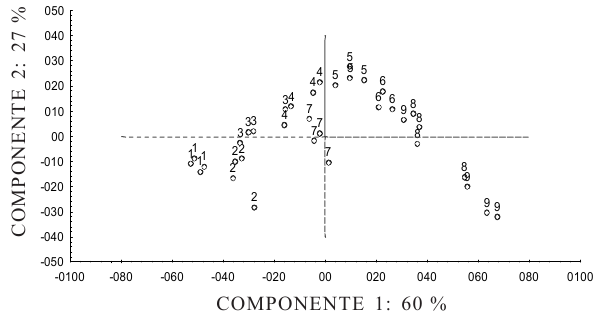
Figura 4. Projeção dos dois componentes principais retidos na análise das onze variáveis do solo, com as variações explicadas por cada componente. Os números sobre os círculos que representam as observações identificam o tratamento.